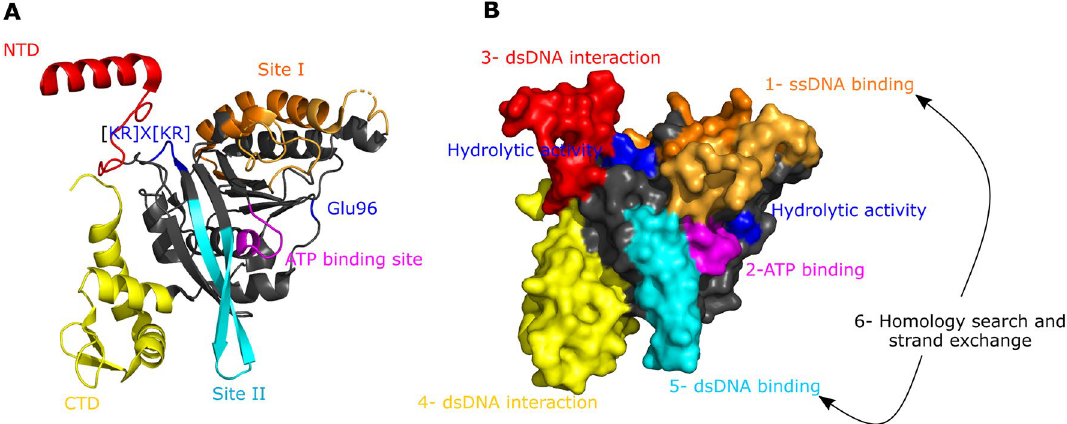
Figure 1. RecA 3D structure and its relationship with the activities involved in recombination. The different domains of the protein are coloured as follows: in red, the N-terminal domain (NTD); in pink, the ATP binding site; in blue, the hydrolytic residue Glu96 and the hydrolytic motif [KR] × [KR]; in orange, site I; in cyan, site II; and in yellow, the dsDNA gateway in the C-terminal domain (CTD). ( A) RecA structure is shown as a cartoon representation. The different sites are indicated. ( B) RecA structure is shown as a surface representation. The different steps of recombination are indicated. First, the nucleoprotein filament is formed by binding of single- stranded DNA (ssDNA) to site I (step1). Then, the filament is activated by binding of the cofactor ATP to the ATP binding site (step 2). Next, RecA performs a homology search to find a homologous double-stranded DNA (dsDNA). In this process, dsDNA interacts first with the NTD (step 3) and then with the CTD (step 4), by which it can move to site II, where it binds (step 5). If the bound dsDNA is homologous to the ssDNA, strand exchange is performed; if it is not, the dsDNA is released (step 6). During these steps, the nucleoprotein filament presents hydrolytic activity, carried out by the [KR] × [KR] hydrolysis motif containing Lys248 and Lys250, which cooperate with Glu96 on the other monomer. The figure was generated using the PyMol program 18 and models provided by Prentiss and Prevost 19